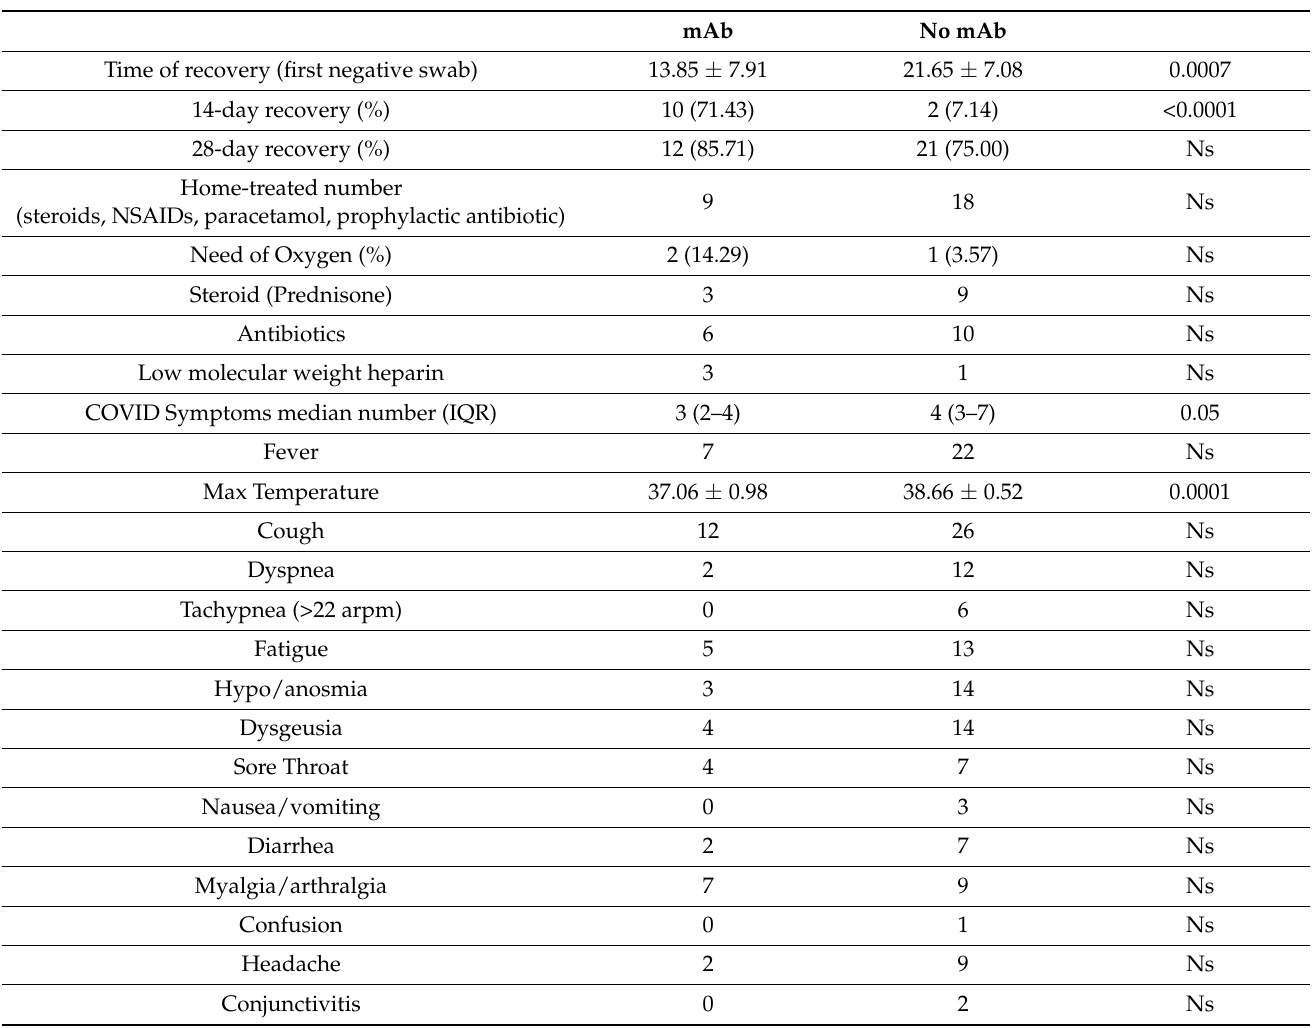
Table 2. Group 1 (mAb) and Group 2 (no mAb) clinical features of the COVID-19 disease during the entire period of the